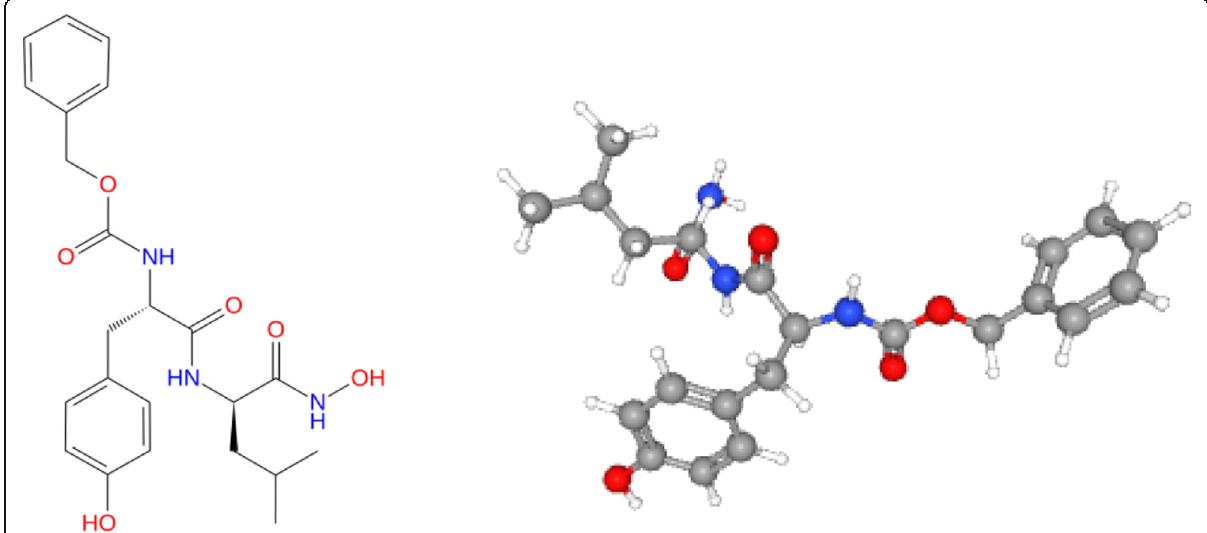
Fig. 3 2D and 3D structure of benzyloxycarbonyl-Tyr-Leu-NHOH (PubChem id: 46173719)